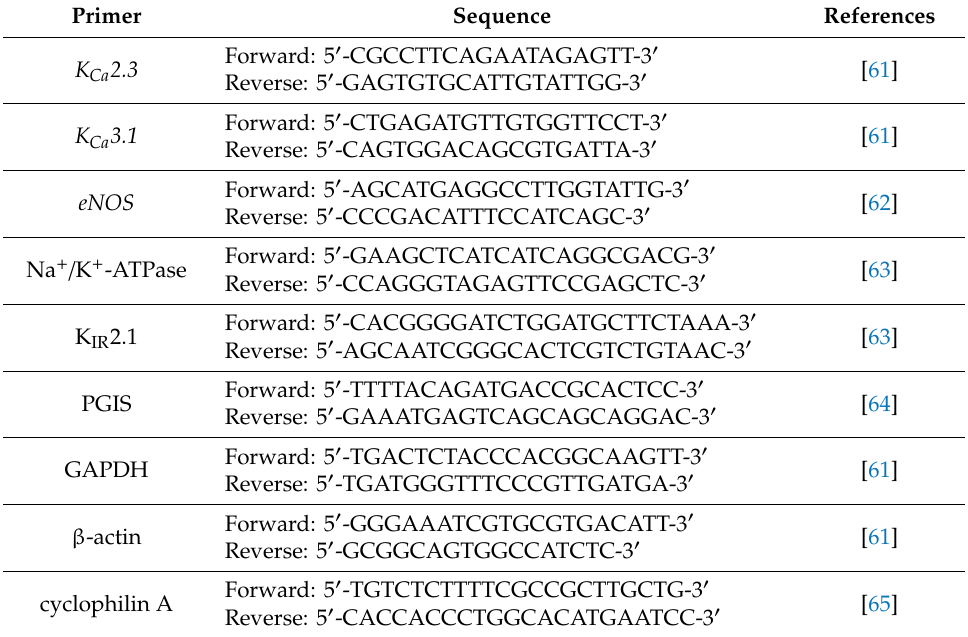
Table 3. RT-qPCR: Primer